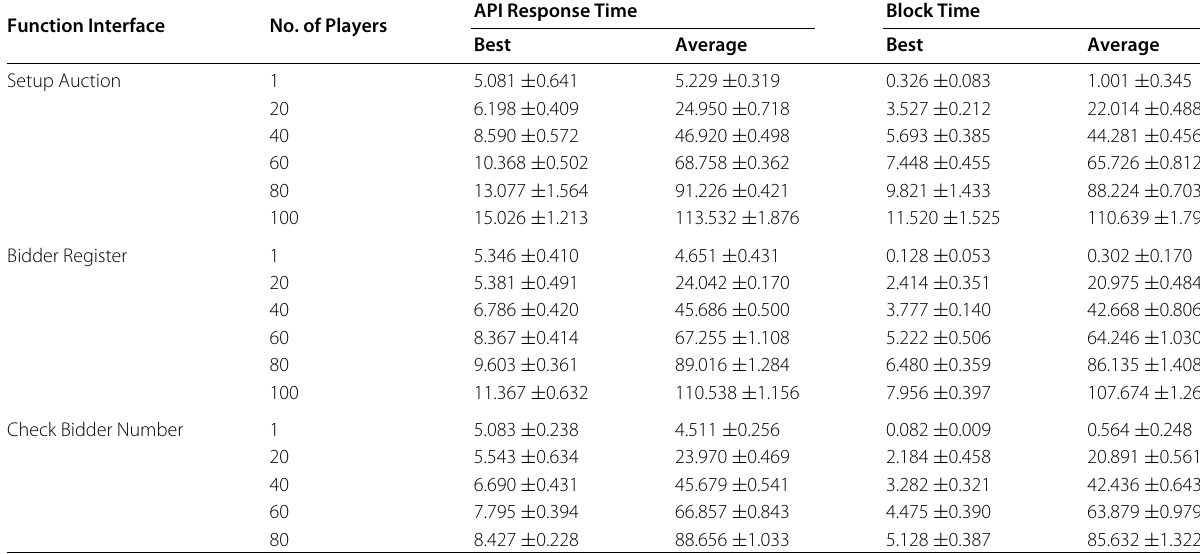
Table 1 Execution latency of the AWESOME contracts with different player numbers (s) Function